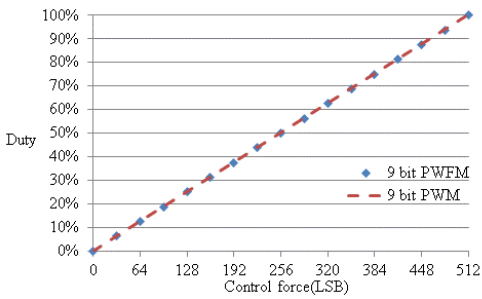
Figure 8. Curves of duty cycle versus control force for the PWFM and PWM strategies.